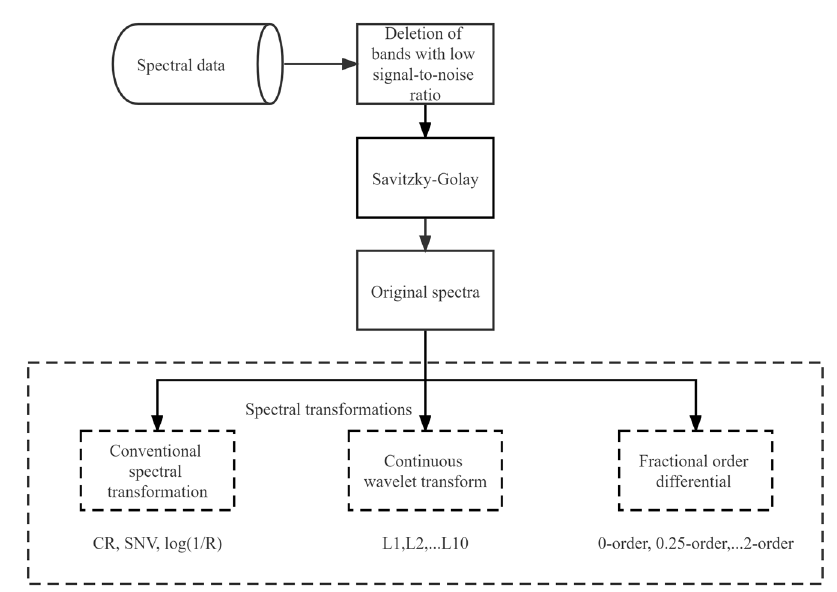
Figure 2. The workflow of data processing.